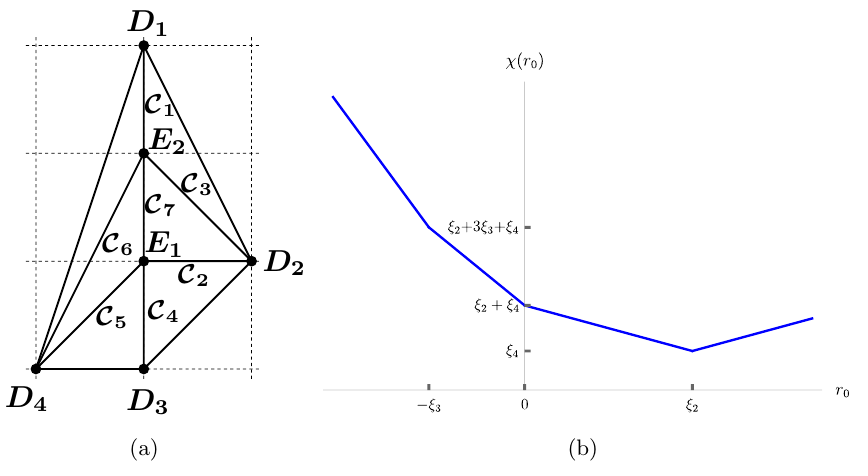
Figure 5 . Resolution (a) of the E 12 ; 2 singularity and its vertical